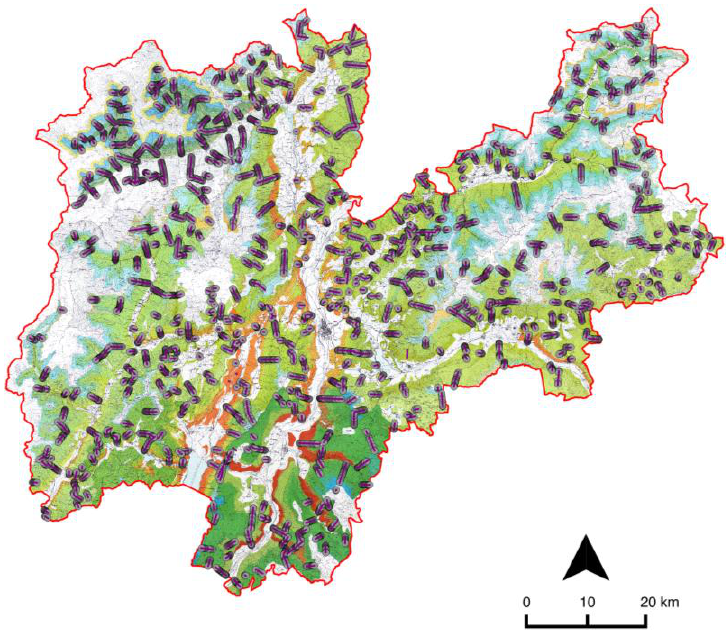
Figure 4. Distribution of the transects and sampling points around the entire study area.